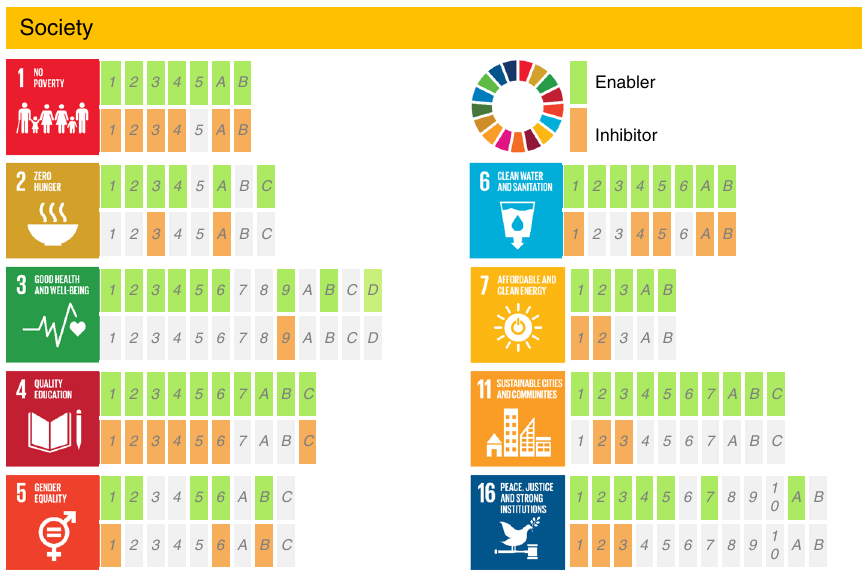
Fig. 2 Detailed assessment of the impact of AI on the SDGs within the Society group. Documented evidence of positive or negative impact of AI on the achievement of each of the targets from SDGs 1, 2, 3, 4, 5, 6, 7, 11, and 16 (https://www.un.org/sustainabledevelopment/). Each block in the diagram represents a target (see the Supplementary Data 1 for additional details on the targets). For targets highlighted in green or orange, we found published evidence that AI could potentially enable or inhibit such target, respectively. The absence of highlighting indicates the absence of identi fi ed evidence. It is noteworthy that this does not necessarily imply the absence of a relationship. (The content of of this fi gure has not been reviewed by the United Nations and does not re fl ect its